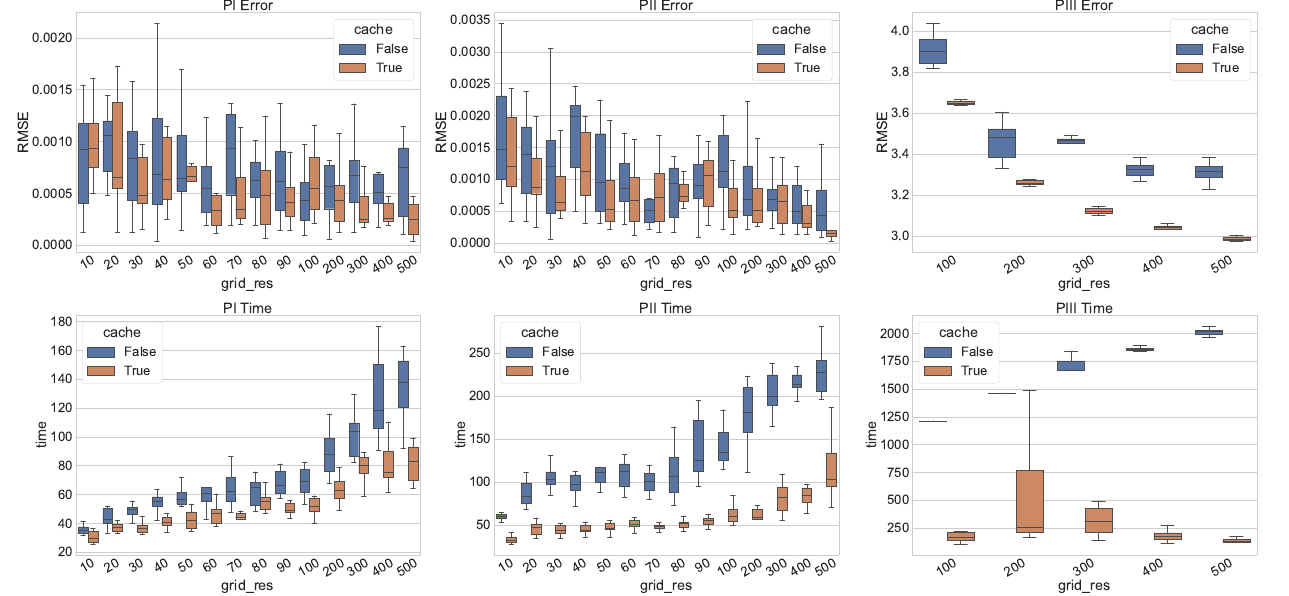
Figure 7. A summary of Painlevé I–III experiment runs. Different colors represent runs with and without an initial guess.